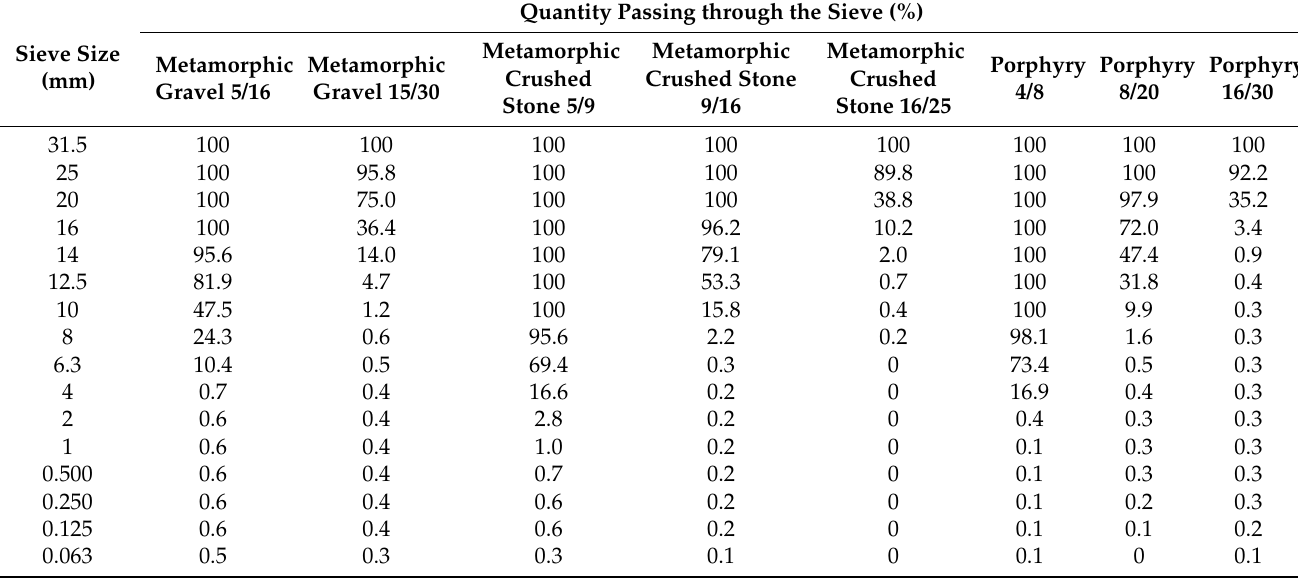
Table 7. Particle size dimension of metamorphic gravel, metamorphic crushed stone and porphyry samples analyzed, expressed in percentage for each sieve selected and expressed in